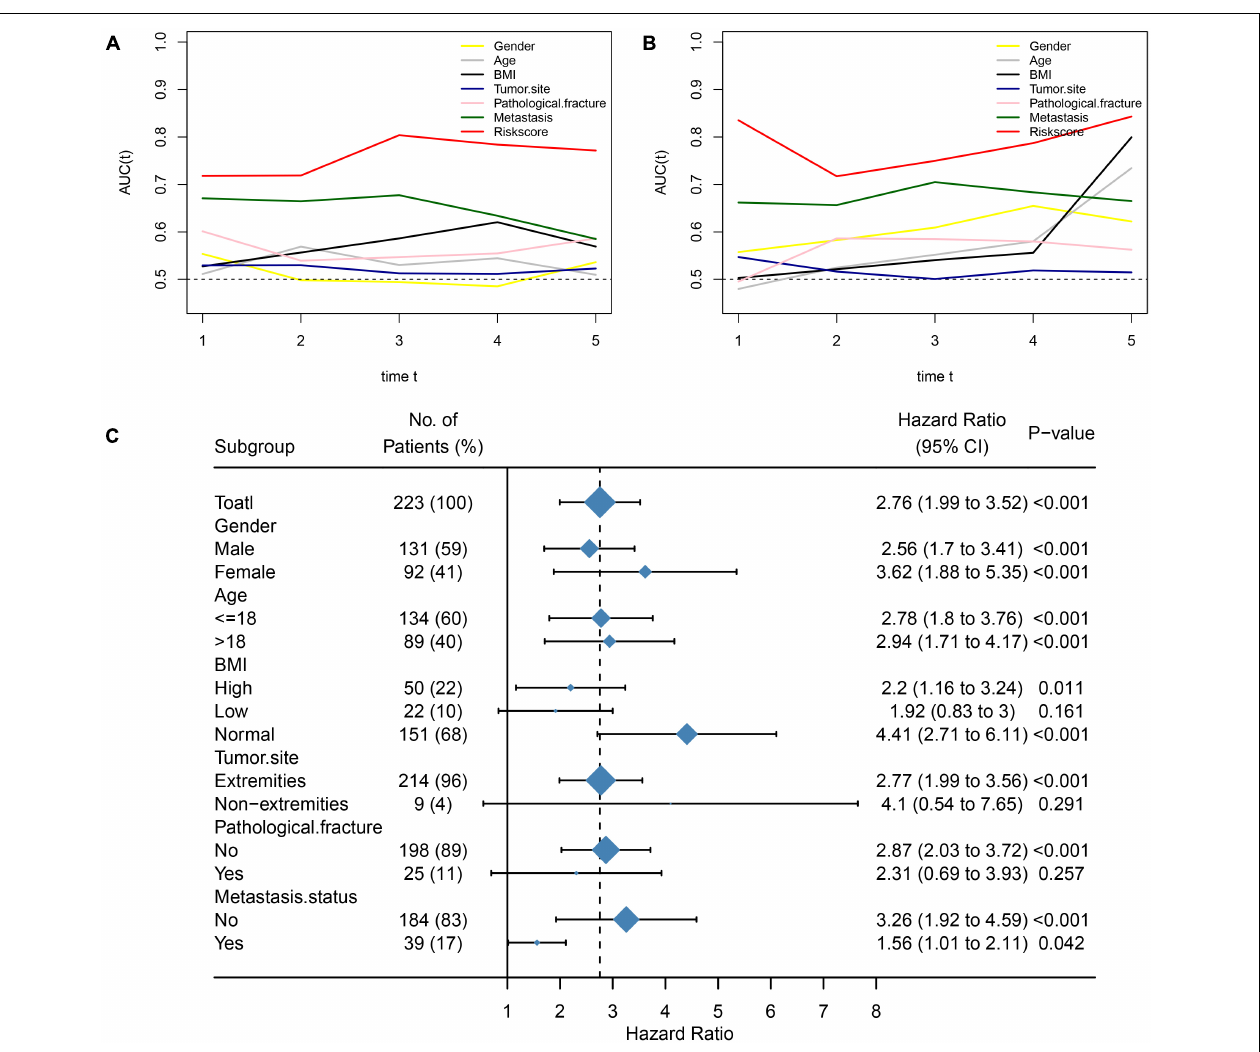
FIGURE 3 | Comparison of NMRS with clinical features and stability of NMRS prediction ability. (A,B) Time-dependent ROC curves for NMRS vs. clinical characteristics in terms of predictive ability (training set and validation set); (C) Forest plots showing the predictive power of NMRS in various